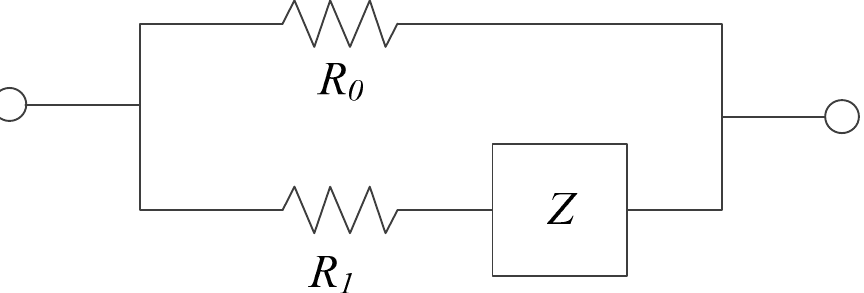
Figure 1. Equivalent electrical circuits for the Cole–Cole model of the underwater active electric field.